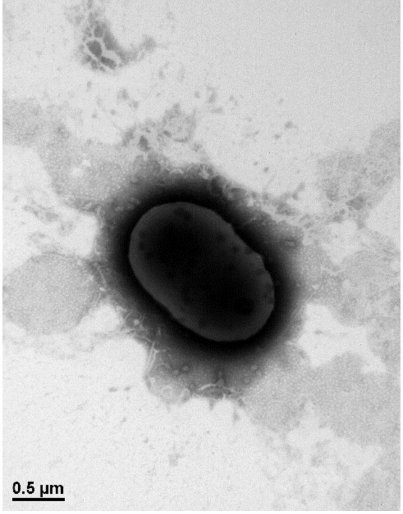
Figure 2. Transmission electron microscopy of cells of the strain